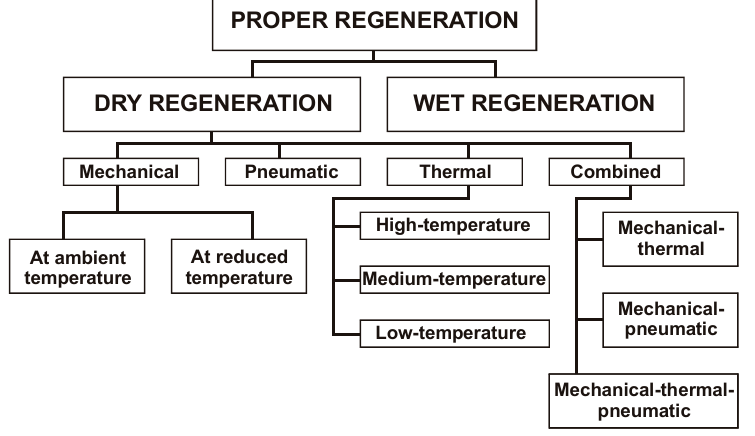
Figure A2. Schematic view of proper (secondary) regeneration methods used [3].